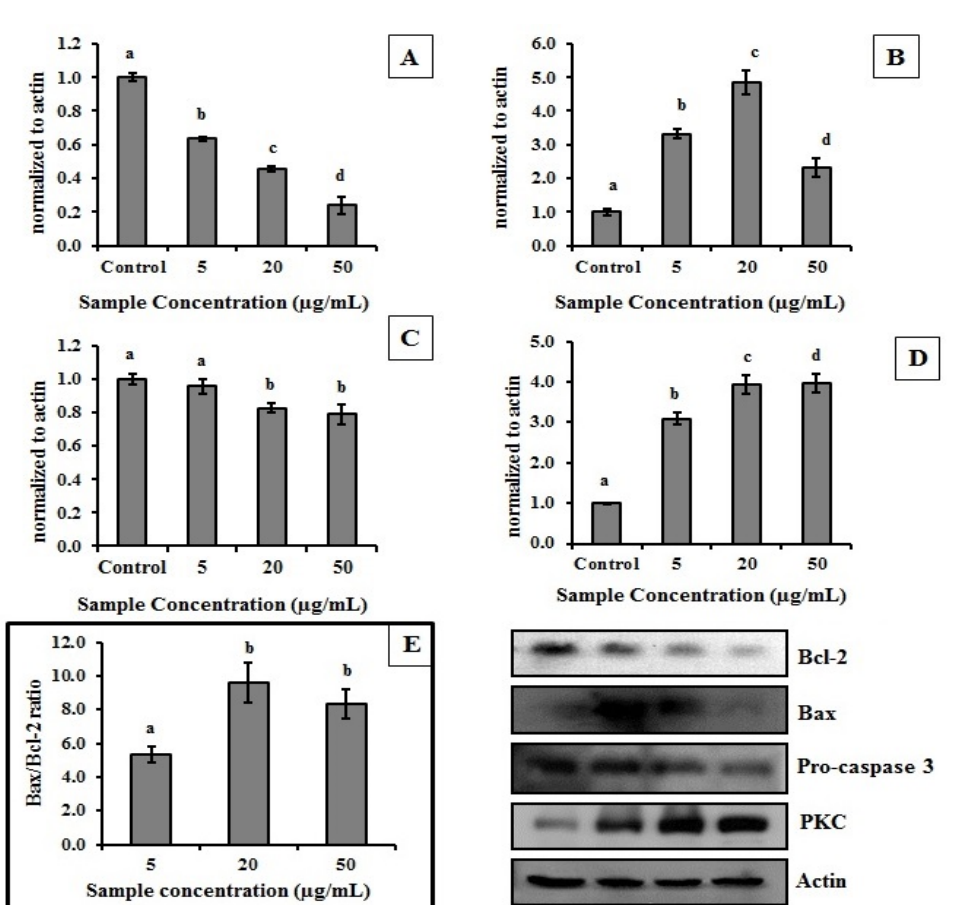
Figure 6. Effect of MEC on several proteins levels involved in cell death. Graphic represents the relation of protein normalized to actin. ( A ) Bcl-2 protein; ( B ) Bax protein; ( C ) pro-Caspase 3; ( D ) PKC – Protein kinase; ( E ) in the box, Bax/Bcl-2 ratio. In the upper right are the images of the western blot of proteins involved. Letters a,b,c,d Indicate significantly differences between different concentrations of the same